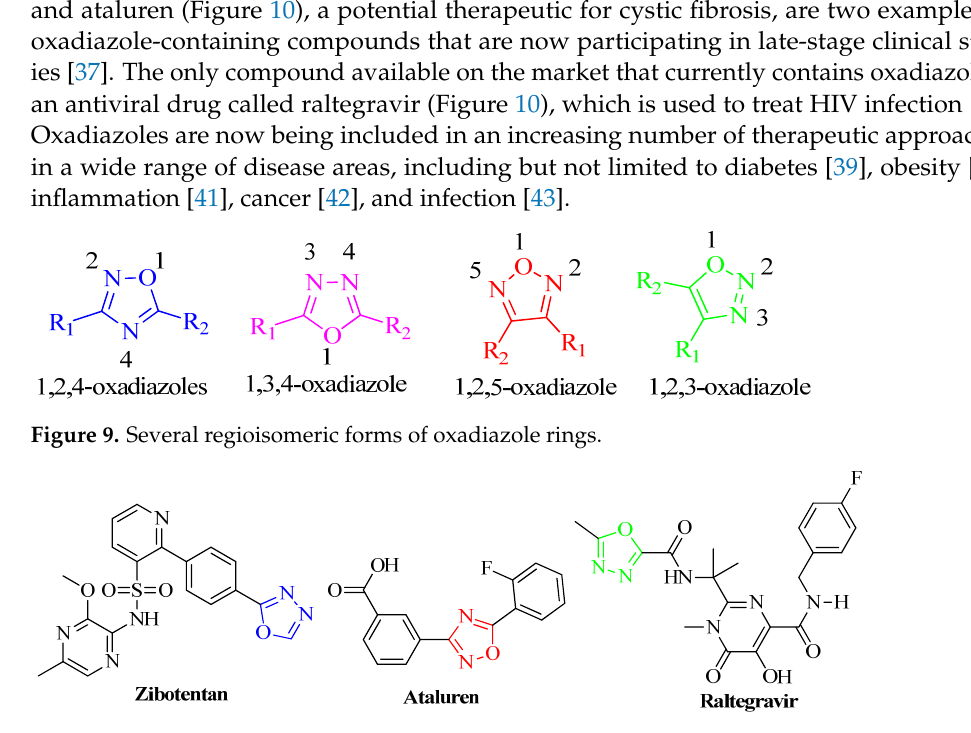
Figure 10. Oxadiazole structure-containing drugs.